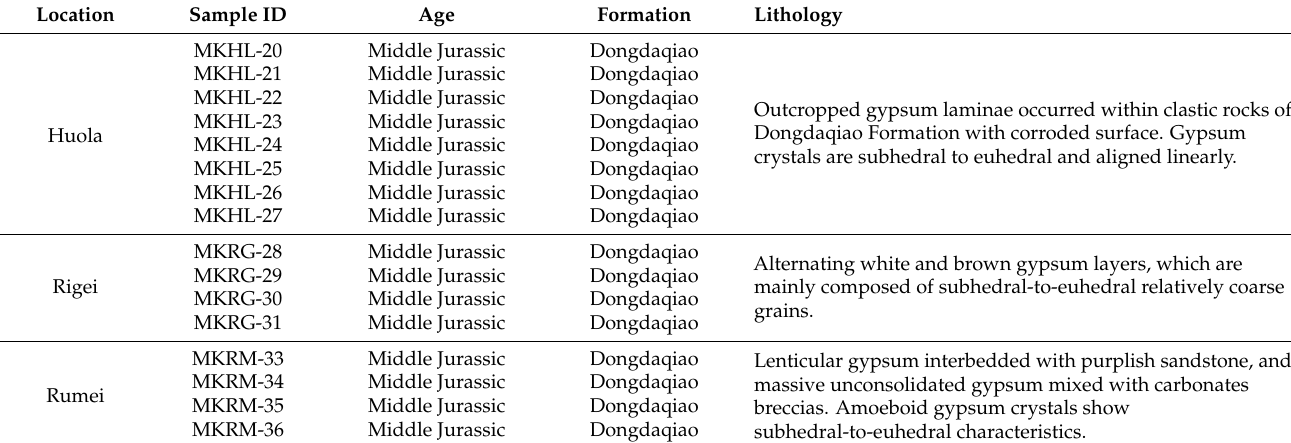
Table 1. Description of Middle Jurassic sulphates from the Qamdo Basin.